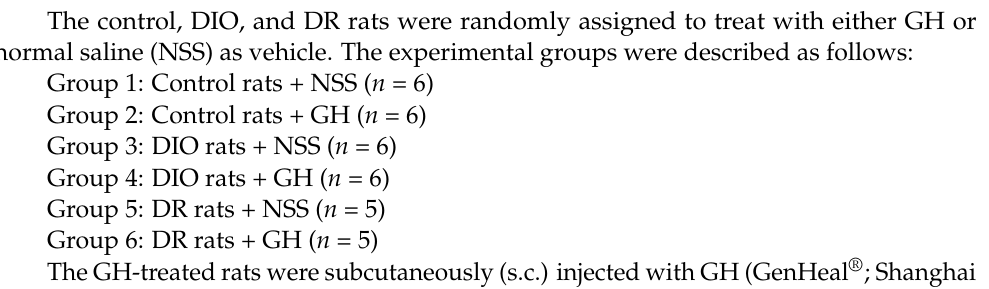
Figure 1. ( a ) The experiment timetable. ( b ) The HC-feeding rat groups after 6-weeks of dietary